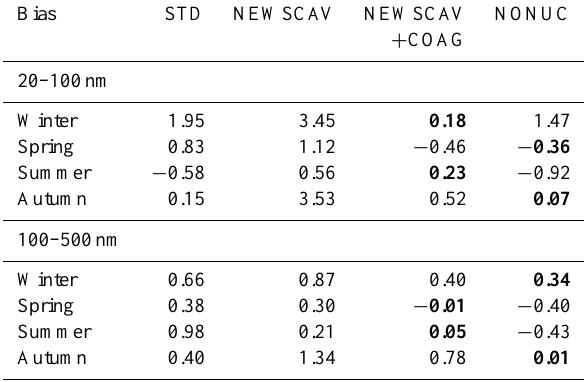
Table 2. Model–measurement fractional bias (Eq. 6) for total num- ber of aerosols with diameters of 20–100 and 100–500nm at Alert (in reference to Fig. 3). Bias values closest to zero for each season are highlighted in bold.